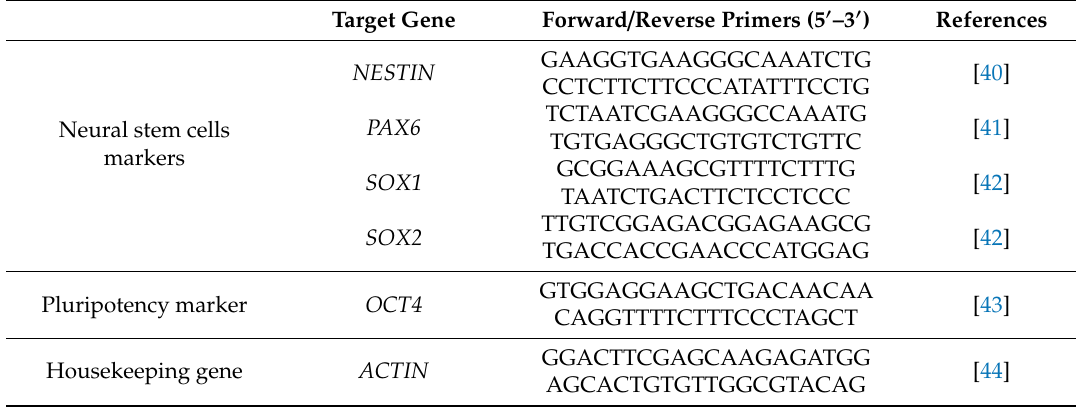
Table 1. Oligonucleotide primers for RT-PCR analysis of cell di ff erentiation